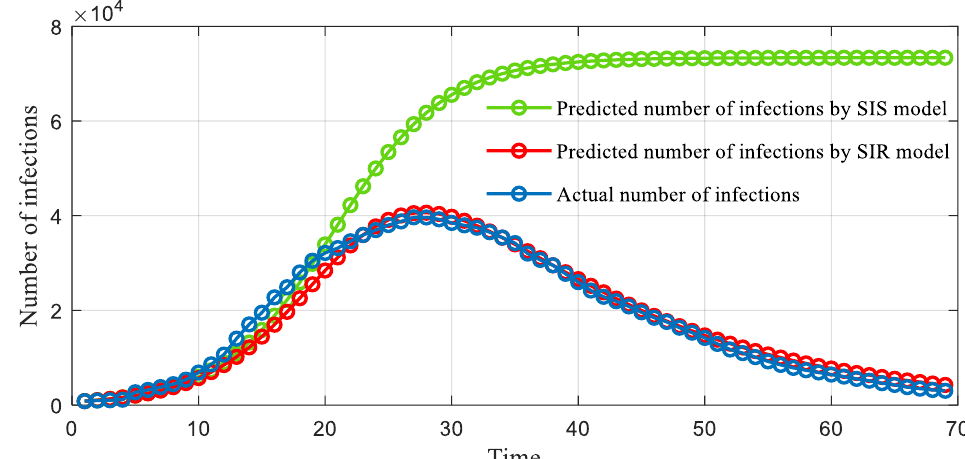
Figure 2. Comparison of actual and predicted infections: the green dots denote the infections predicted by the SIS model, the red dots denote the infections predicted by the SIR model and the blue dots denote the actual infections.